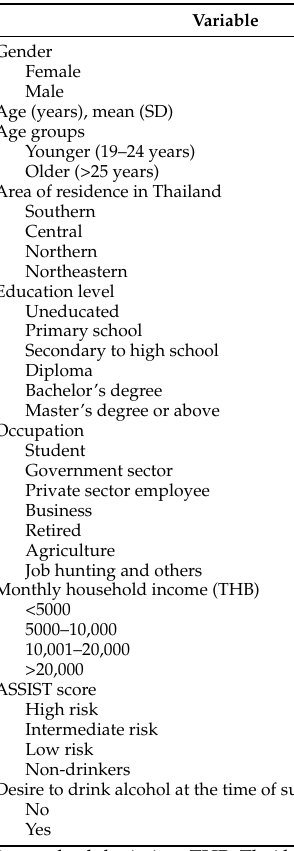
Table 1. Sociodemographic characteristics of the participants ( n = 1185).